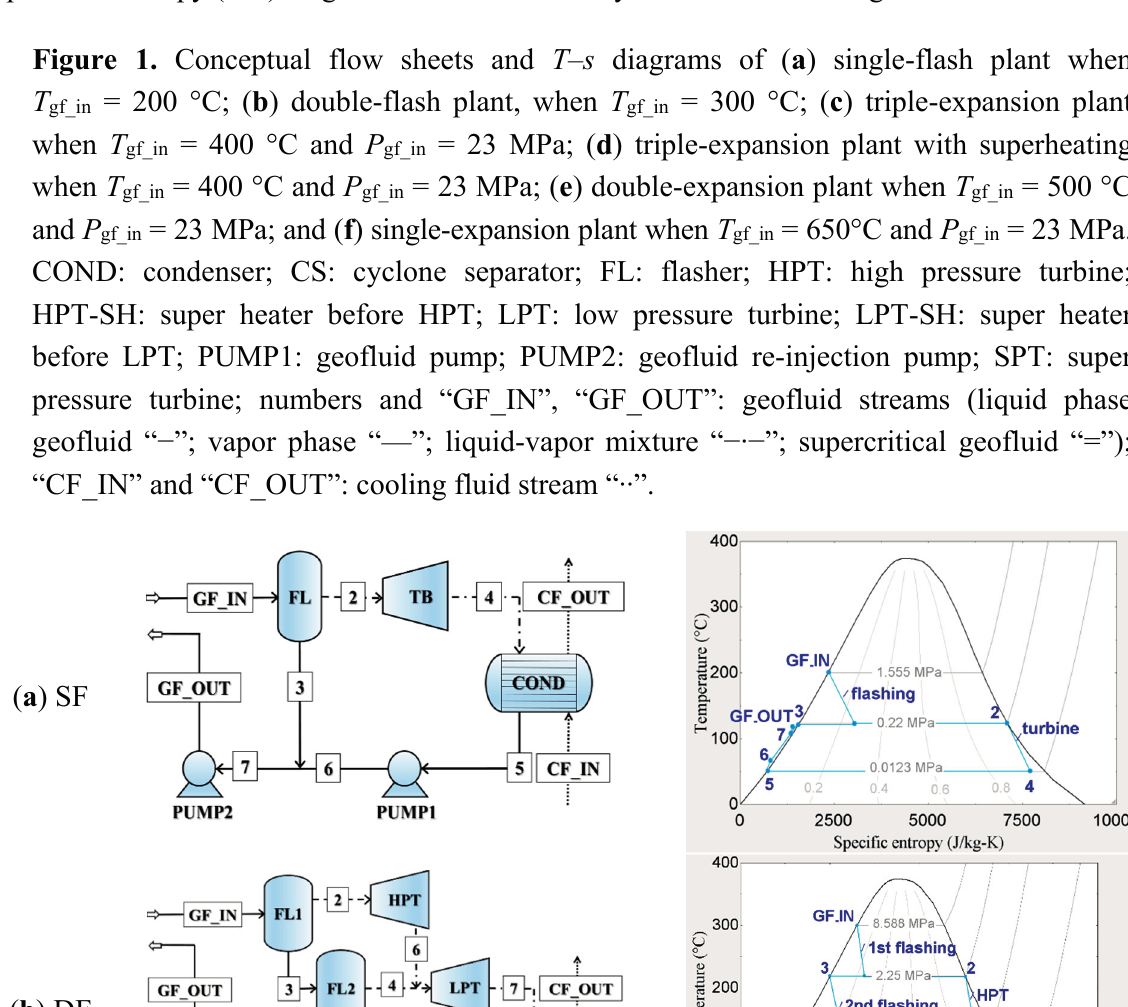
Figure 1. Conceptual flow sheets and T–s diagrams of ( a ) single-flash plant when T gf_in = 200 °C; ( b ) double-flash plant, when T gf_in = 300 °C; ( c ) triple-expansion